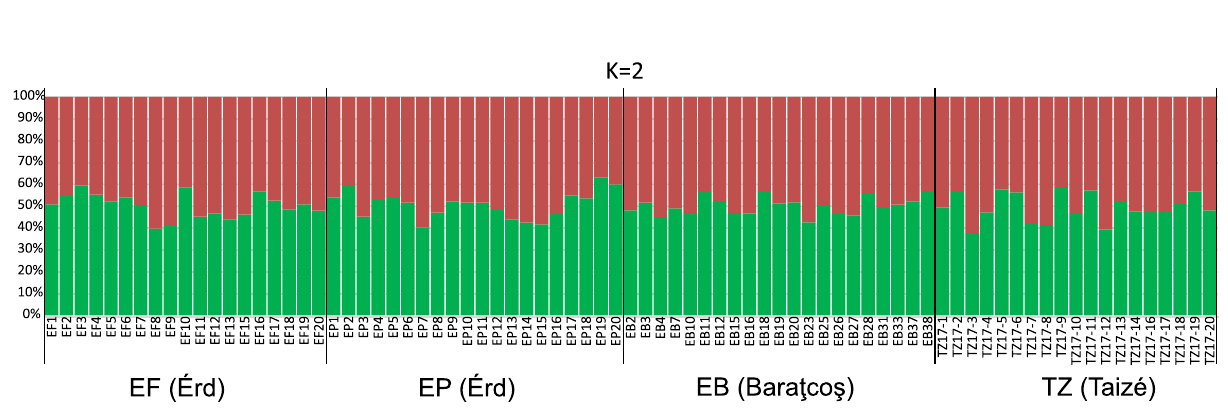
Figure 4. A posteriori assignment of the studied Polyommatus icarus individuals into two genetic clusters that is the most likely number of clusters in our genetic dataset as indicated by a structure analysis and its summary statistics generated by